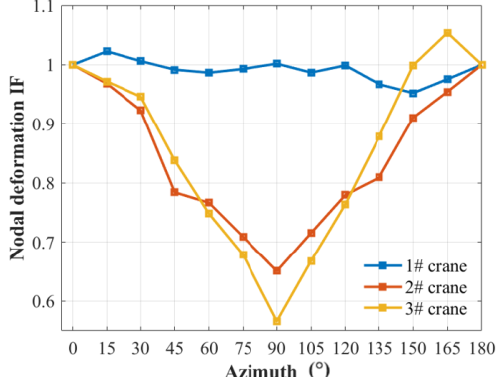
Figure 24. IF for peak deformation of the 174# node of boom-up crane.